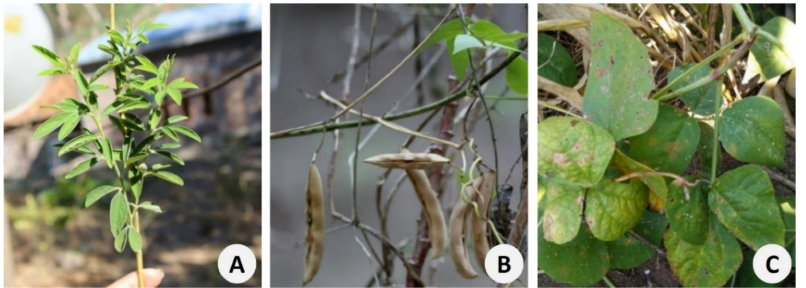
Figure 4. ( A ) Cajanus cajan . Kefamenanu (Kupang); ( B ) Phaseolus lunatus . Kefamenanu (Kupang); ( C ) Vigna unguiculata Beseuc (Cova Lima) (Photos L.